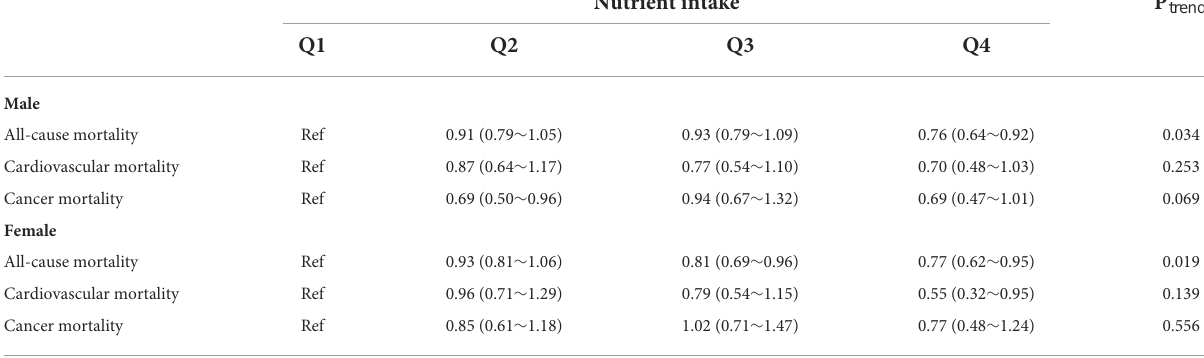
TABLE 4 Hazard ratio and 95% CIs for all-cause and cause-specific mortality according to quartiles of dietary folate intake after excluding participants with cardiovascular disease at